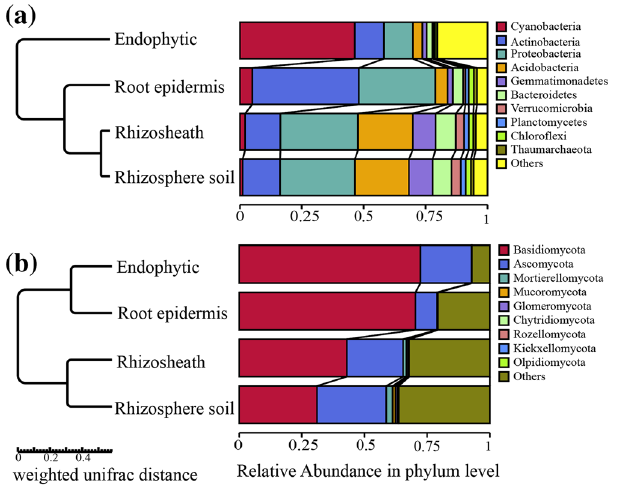
Figure 4. UPMGA clustering tree diagram of species composition at bacteria and fungi phyla level. In ( a ) and ( b ) refer to the UPMGA cluster tree of bacteria and fungi respectively. Both UPMGA cluster trees are based on the relative abundance data of the sample species. The length of the branch represents the distance between samples, and if the community composition of samples is similar, they are clustered into the same cluster in the cluster tree. The relative abundance was the average of 5